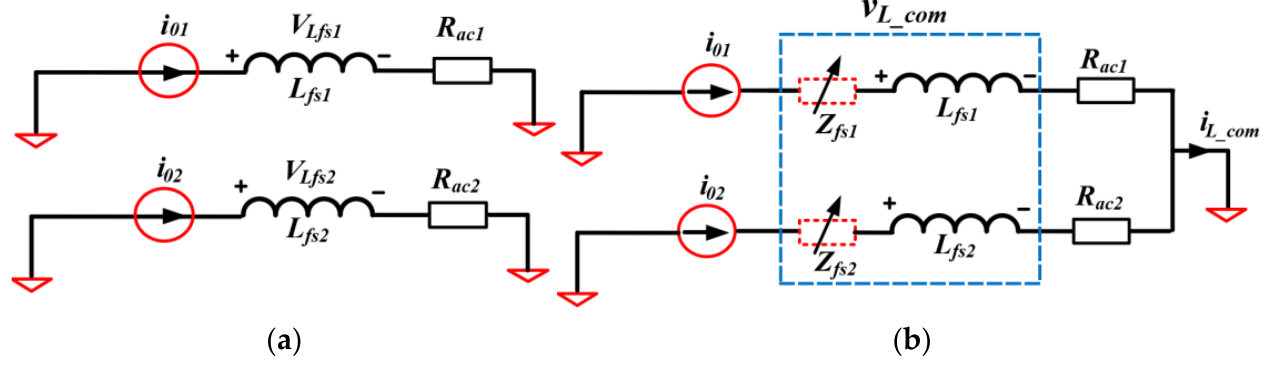
Figure 28. Equivalent circuit of inductors in LCC-BP receiver coils ( a ) without common inductor connection, and ( b ) with common inductor connection.